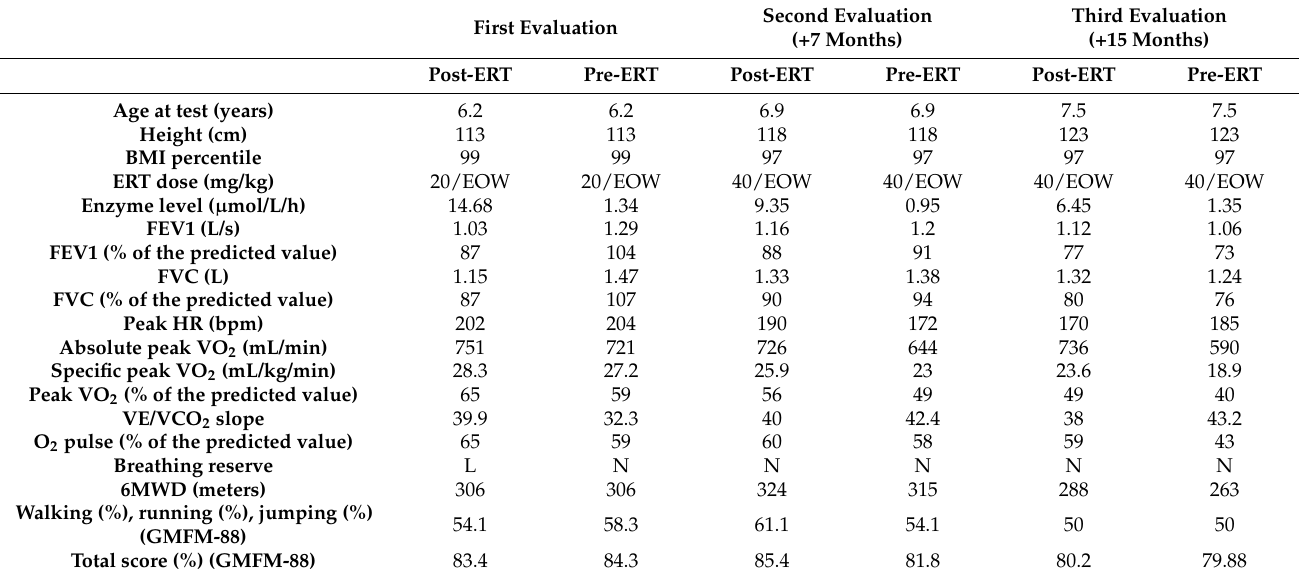
Table 3. Patient